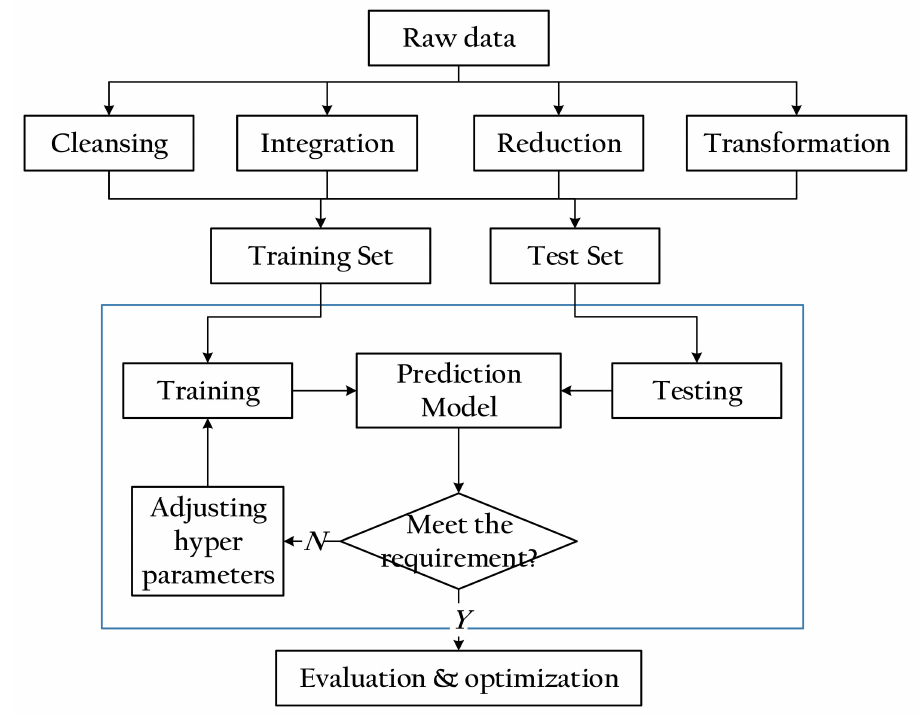
Figure 13. Flow chart of establishing prediction